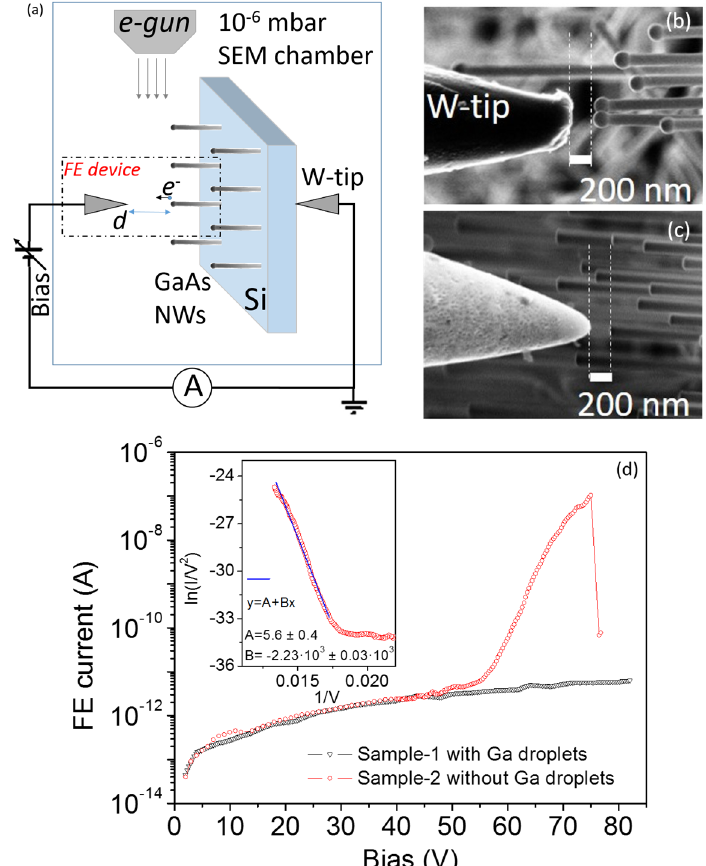
Figure 1. ( a ) Field emission setup realized inside a SEM chamber using two nano-manipulated tungsten tips. Image of FE device with the W-tip at d = 200 nm from the NWs of ( b ) Sample-1 (NW tips covered by Ga droplets) and ( c ) Sample-2 (free NW Tips). The SEM sample stage was rotated to allow for the precise estimation of the tip-sample distance. ( d ) FE current-voltage characteristics measured in the voltage range 0–80 V for both samples. Inset: Fowler ‐ Nordheim plot ln I / V 2 vs. V showing linear behavior y = A + B x with B = ( − 2.23 ± 0.03 ) × 10 3 and A = ( 5.6 ± 0.4 ) to confirm the FE nature of the measured current for Sample ‐ 2.